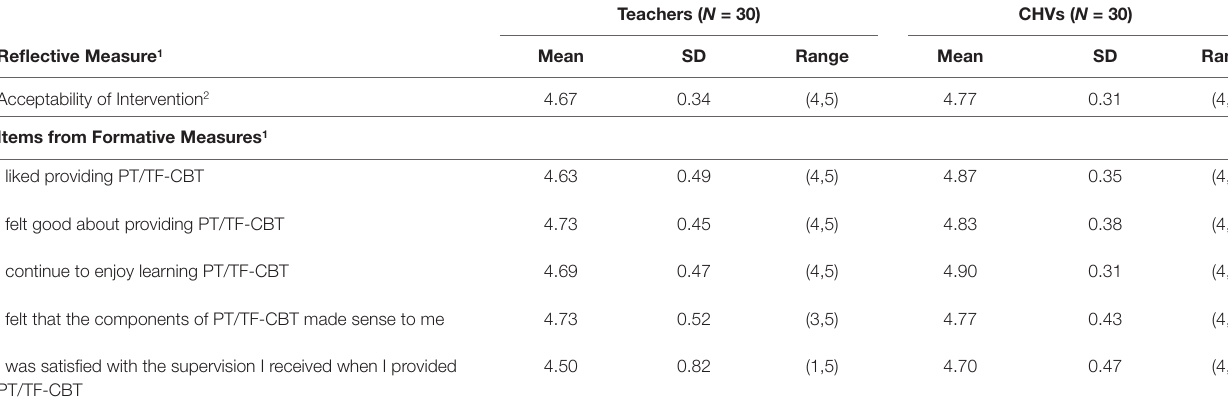
TaBLE 2 | Reflective and Formative Measures of Acceptability among Teachers and CHVs at Post-Implementation.